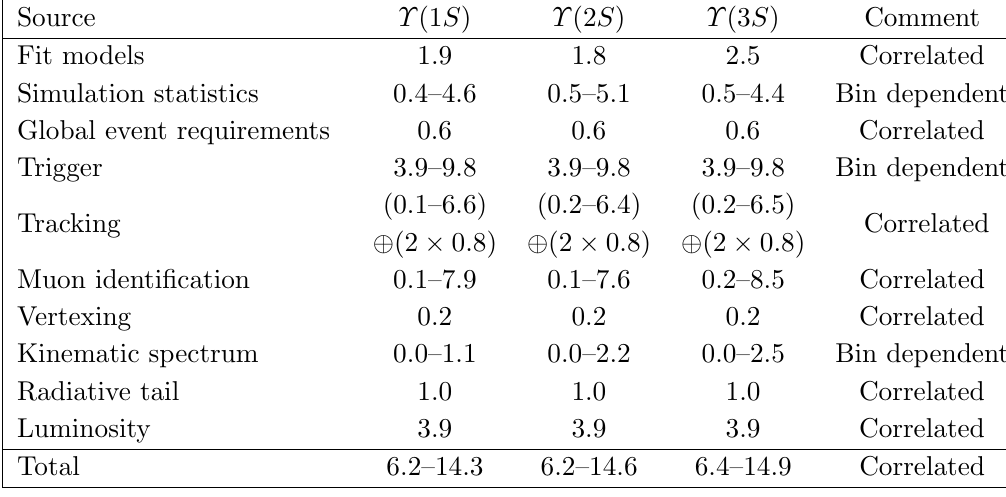
Table 1 . Summary of the relative systematic uncertainties (in %) on the (cid:7) production cross-sections times dimuon branching fractions. Some of the uncertainties are correlated between intervals. For the trigger, track reconstruction and muon identi(cid:12)cation e(cid:14)ciencies, the uncertainties are larger in the high rapidity region. The uncertainties on the tracking e(cid:14)ciency account for both the limited size of the control samples ((cid:12)rst parenthesis) and the impact of di(cid:11)erent multiplicity between data and simulation on each track (second